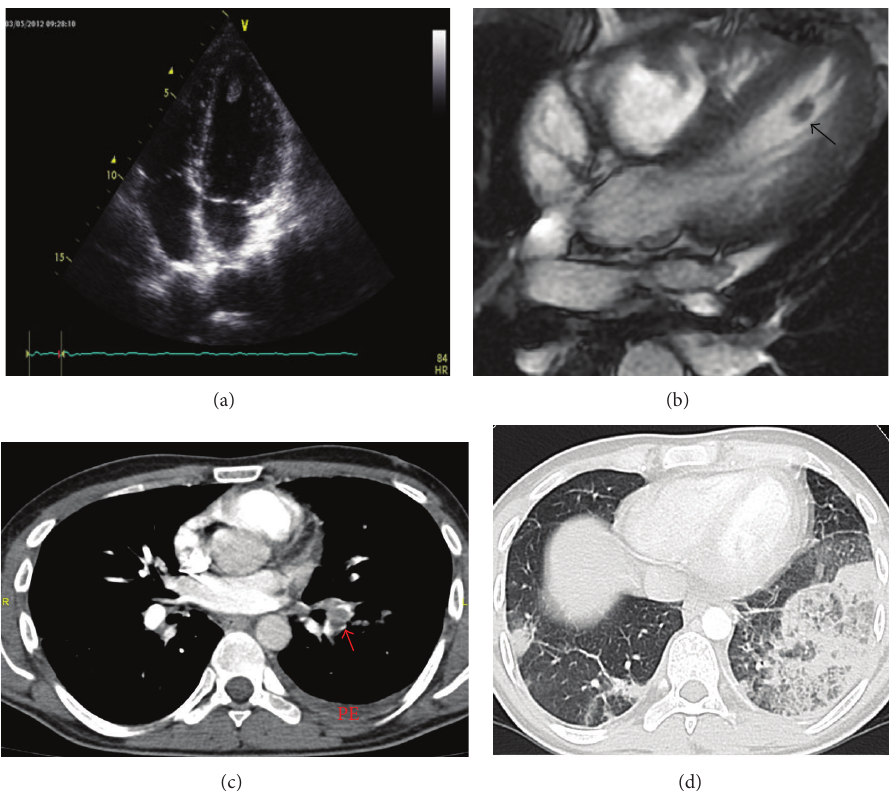
Figure 1: (a) Transthoracic echocardiographic apical four-chamber view shows a thrombus in the apex of the left ventricle. (b) Four-chamber- view MR image obtained with fast imaging steady-state free precession sequence shows pedunculated thrombus (arrow) attached to left ventricularapexwithathinstalk(cineimagesshowedmobilityofthethrombusthroughoutthecardiaccycle).(c)PulmonaryCTangiography shows acute embolus as a filling defect in the left lower lobe artery (arrow). Note the associated left pleural effusion (PE). (d) Lung window setting shows bilateral lower lobe infarcts, more prominent in the left lung.